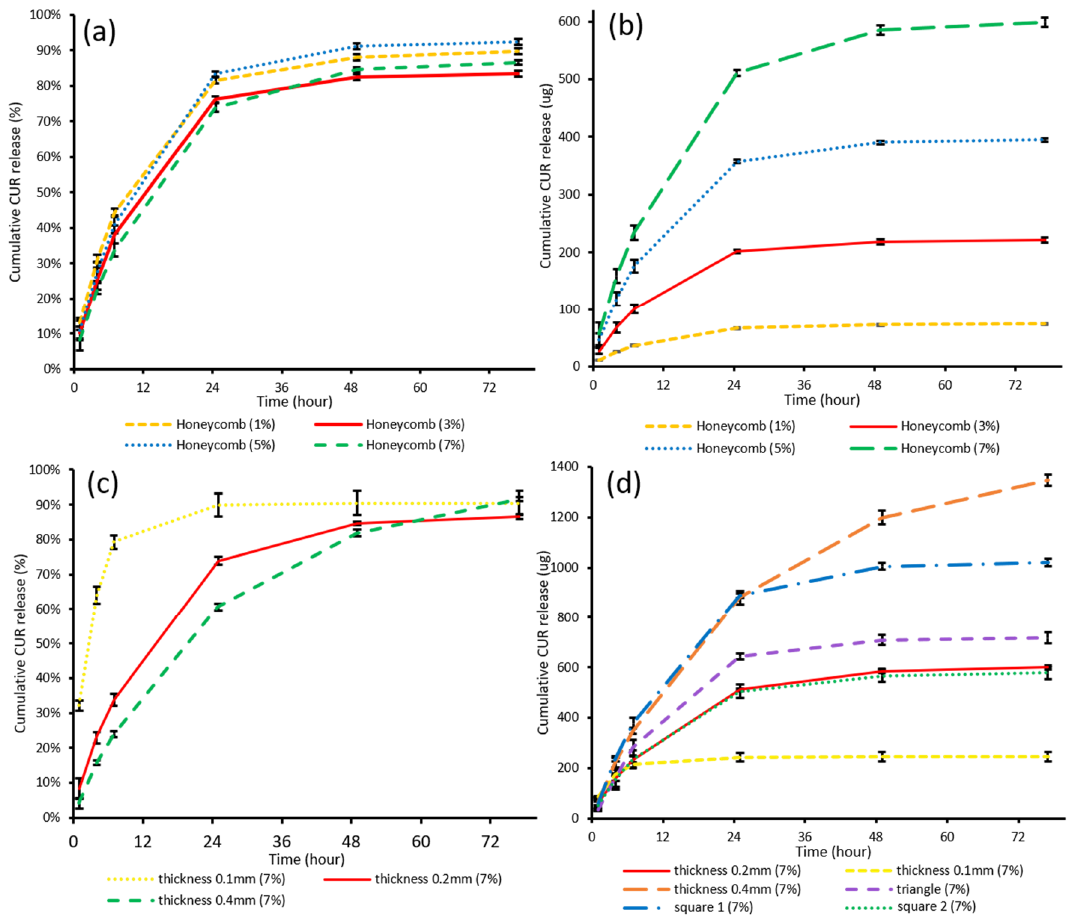
Figure 11. In vitro release profiles of curcumin-loaded PCL scaffolds: ( a ) the cumulative release percentages of scaffolds with loadings 1%, 3%, 3%, and 7%, w / w ; ( b ) the cumulative release amount of scaffolds with loadings 1%, 3%, 3%, and 7% w / w ; ( c ) the cumulative release percentages of 7% ( w / w ) scaffolds with thicknesses 0.1, 0.2, and 0.4 mm; ( d ) the cumulative release amount of 7% ( w / w ) scaffolds with thicknesses 0.1, 0.2, 0.4 mm and pore shapes honeycomb, triangle, square 1 and square 2.